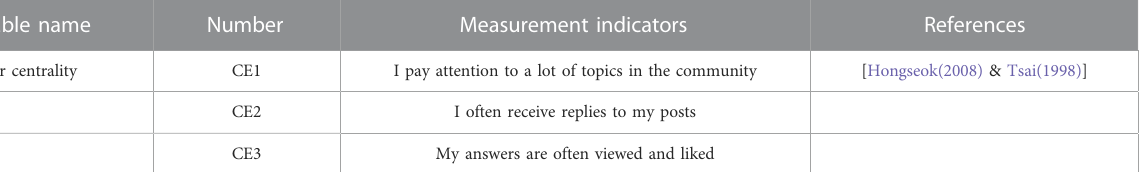
TABLE 2 User centrality measurement